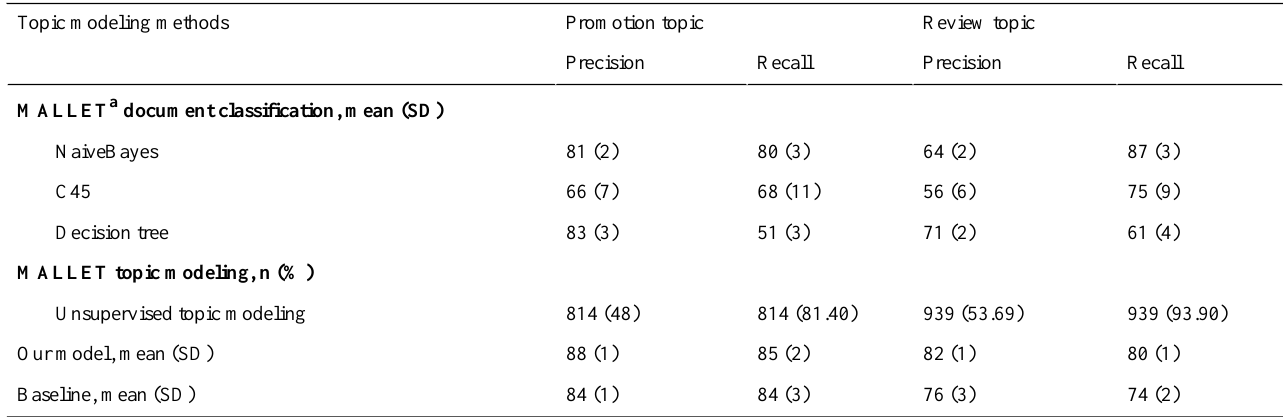
Table 4. The results and 95% CIs of forum posts’topic